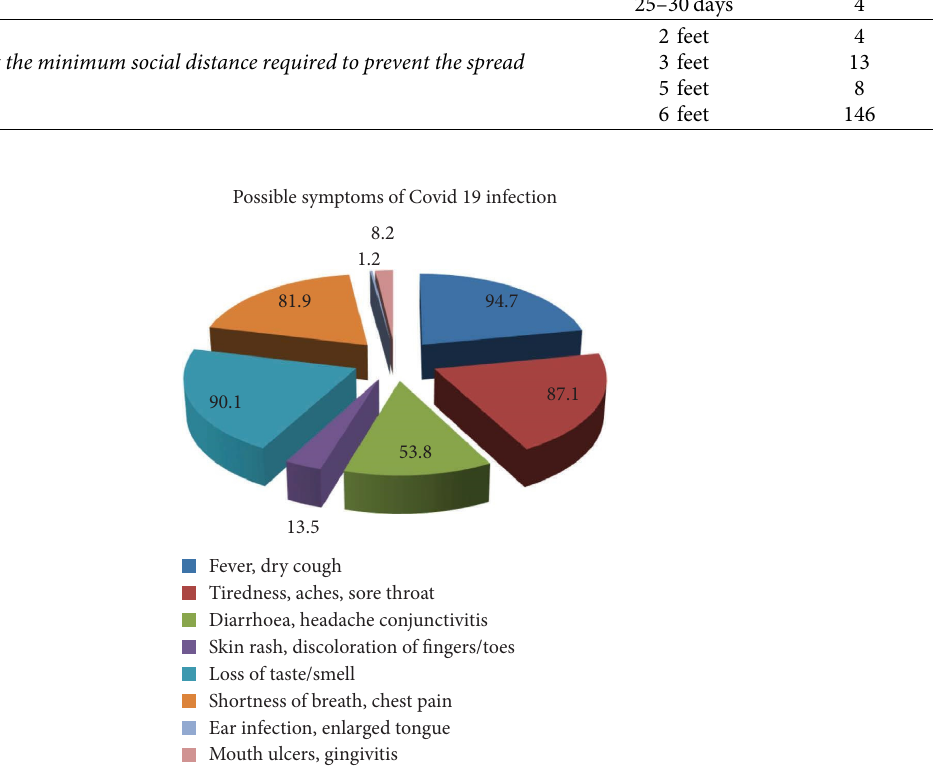
What is the minimum time period for isolation from the last contact with a